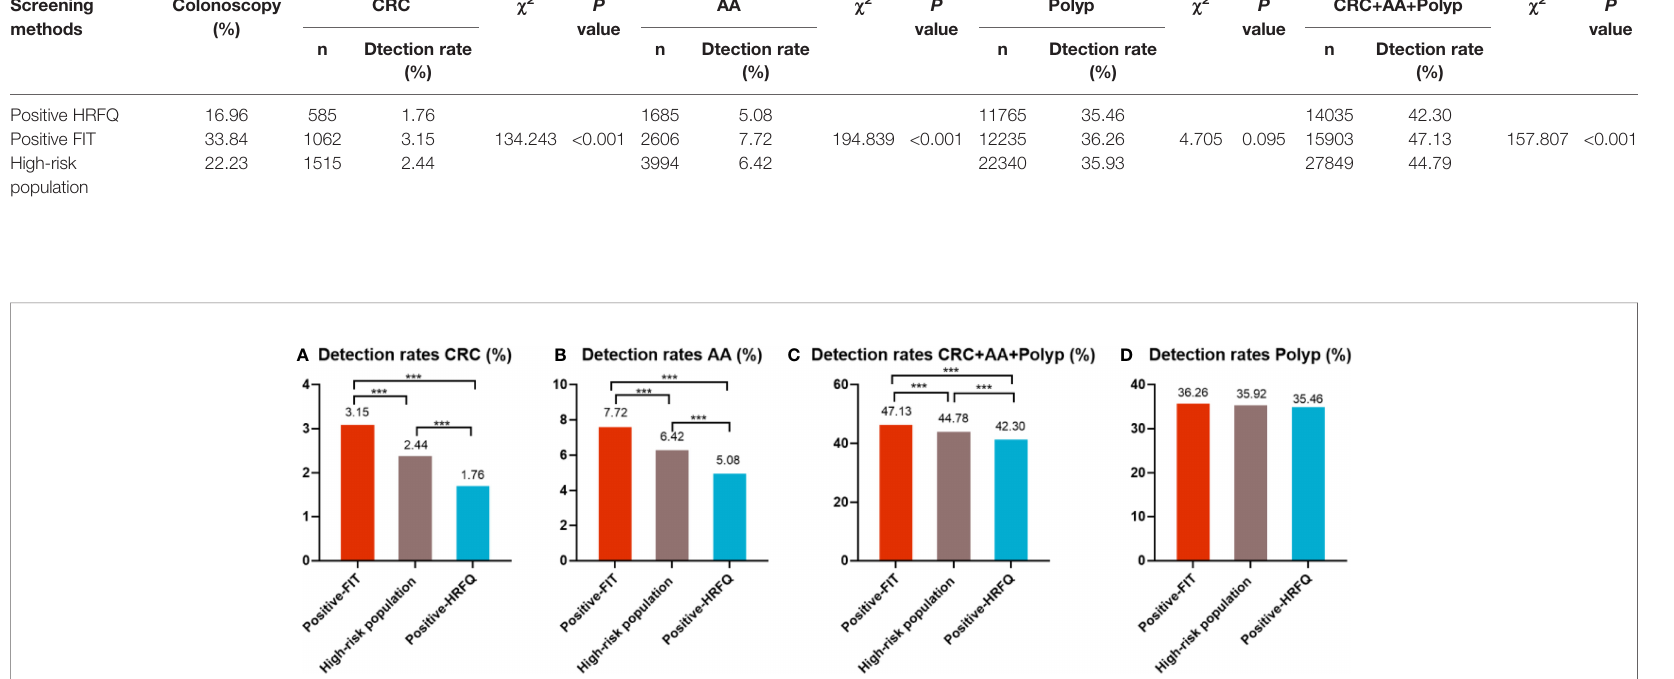
FIGURE 7-1 | Comparison of colonoscopy results of CRC (A) , AA (B) , CRC+AA+polyp (C) and polyp (D) among different screening methods in Tianjin CRC screening program. ***There are signi fi cant differences in detection rates between the different screening methods.